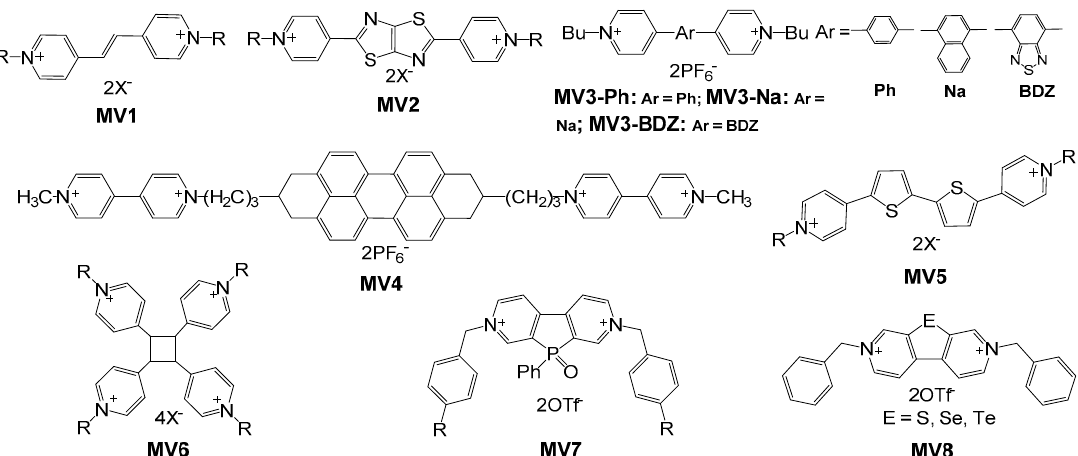
Figure 5. Structures of various viologen derivatives with a bridging group or a spacer between two pyridyl groups.